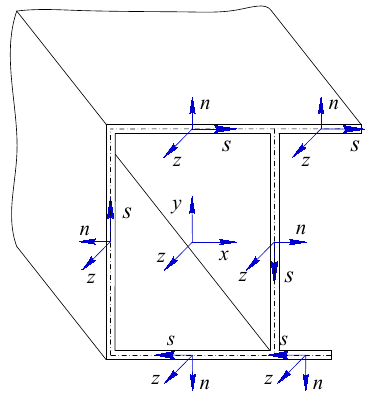
Figure 1. Global ( x , y , z ) and local ( s , n , z ) coordinate systems of a thin-walled structure with a branched cross-section profile.